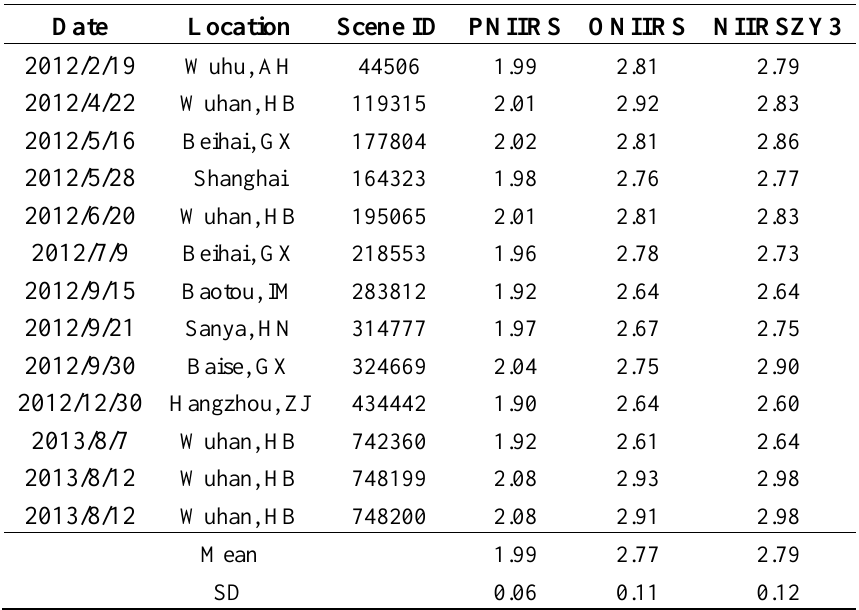
Table 8. Results of the PNIIRS, ONIIRS and NIIRS